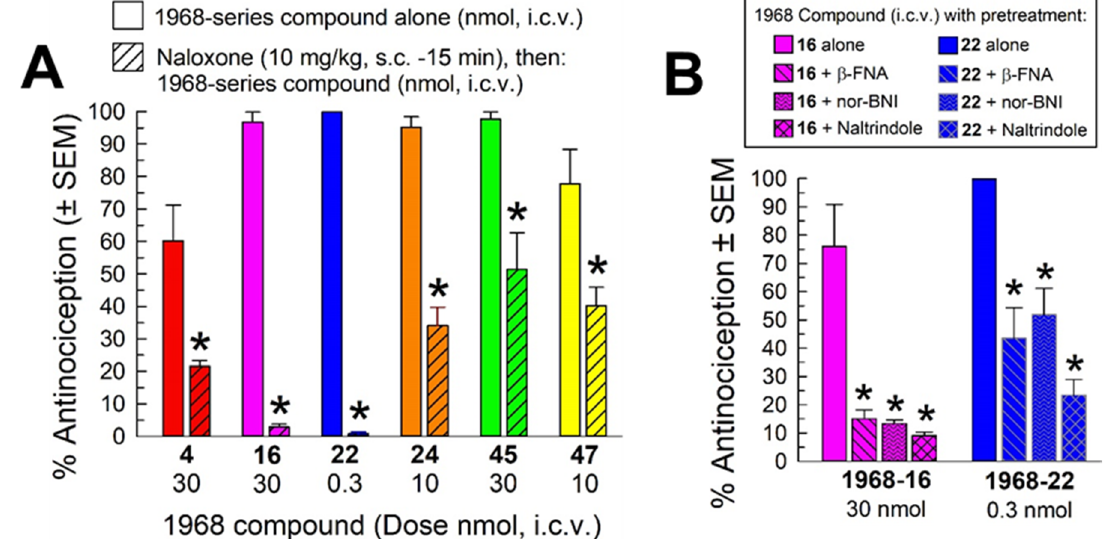
Figure 3. Evaluation of opioid receptor involvement in the antinociceptive activity of the 1968 -series bicyclic guanidine compounds in the 55 °C warm-water tail-withdrawal assay at peak antinociception after ( A ) i.c.v. administration in mice pretreated with the non-selective opioid receptor antagonist naloxone (10 mg/kg., s.c., − 15 min), or ( B ) 20 min after i.c.v. administration in mice pretreated with the selective MOR antagonist β -FNA (10 mg/kg, i.p., − 24 h), the selective KOR antagonist nor-BNI (10 mg/kg, i.p., − 24 h), or the selective DOR antagonist naltrindole (20 mg/kg, i.p., − 20 min). Points represent average % antinociception ± SEM from eight mice for each bar. * significantly different from response of 1968 -series compound alone ( p < 0.05; two-way ANOVA with ( A ) Sidak’s or ( B ) Tukey’s multiple comparisons post hoc test).